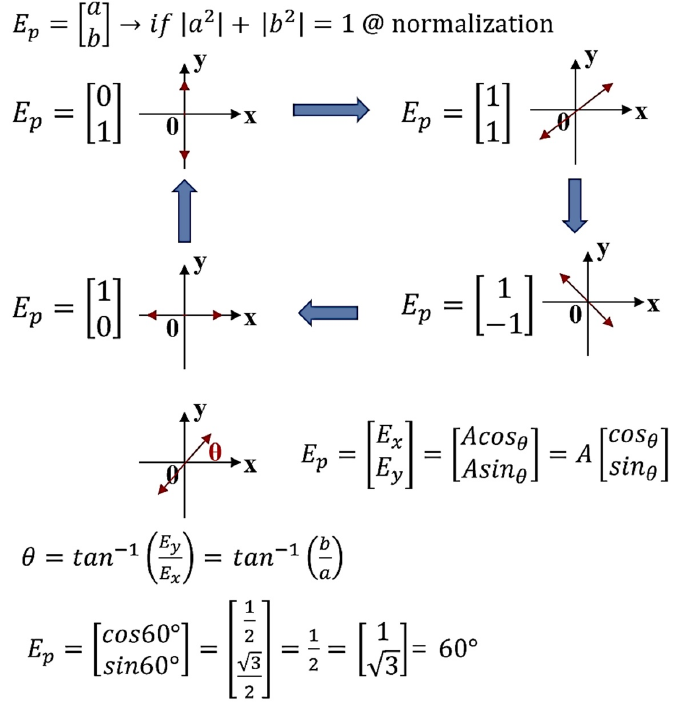
Figure 5. Polarization (specular reflection) propagation direction with respect to the rotation angle of the filter ( E 2 ).